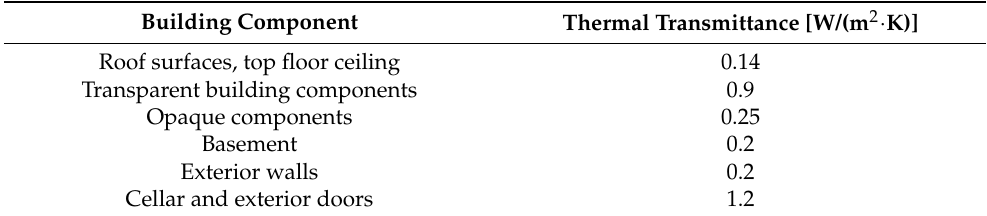
Figure 3. Schematic illustration of the determination of the load profiles using the Hourly Analysis Program (HAP). Table 4. Used building components with corresponding maximum thermal transmittance, own representation according to the KfW-153 standard [21].